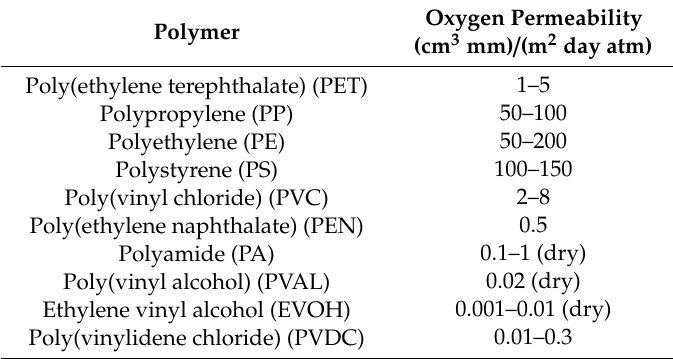
Table 1. Permeability of polymers commonly used in packaging Table 1 . Permeability of polymers commonly used in packaging [49]. 394